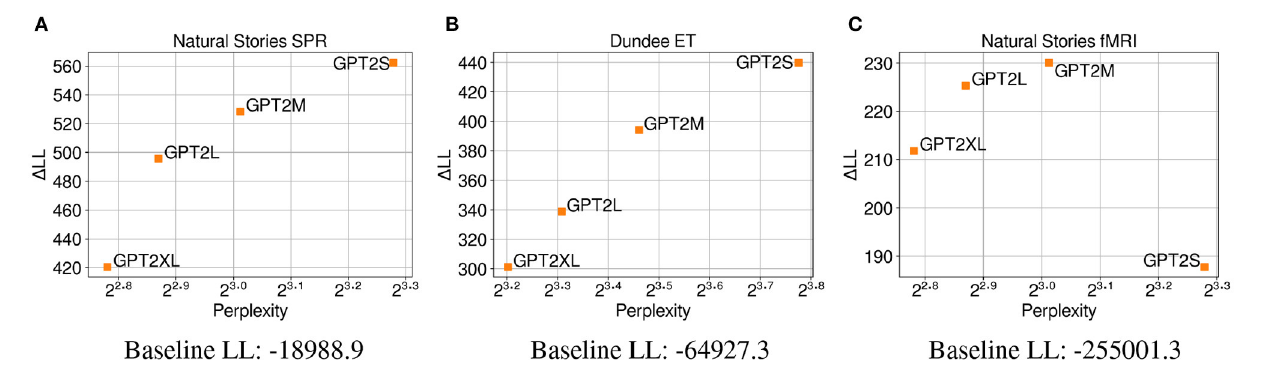
FIGURE 4 | Perplexity measures from each GPT-2 model, and improvements in LMER (A,B) and CDR (C) model log-likelihood from including each surprisal estimate on (A) Natural Stories self-paced reading data, (B) Dundee eye-tracking data, and (C) Natural Stories fMRI data. The difference in by-item squared error between the GPT2S and GPT2M models is significant at p < 0.05 level for the self-paced reading and eye-tracking data, and the difference in by-item squared error between the GPT2M and GPT2XL models is significant at p < 0.05 level for the fMRI